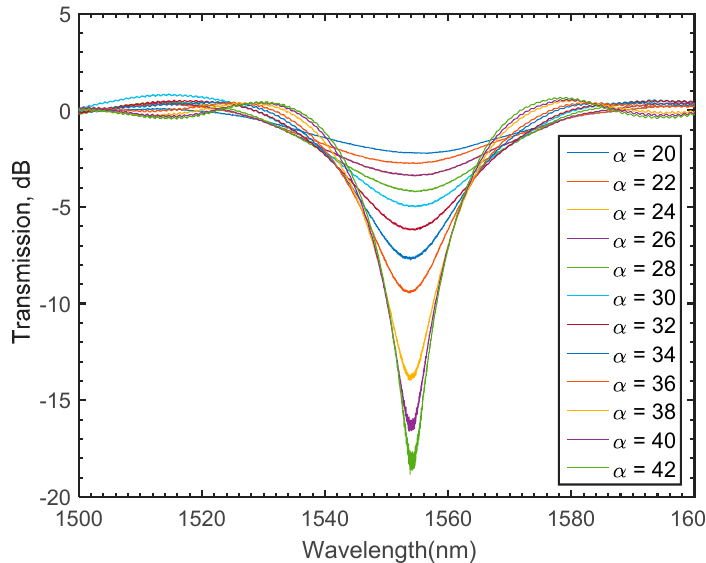
Figure 10. Gradual growth of LPFG in SMF fiber for different number of periods.